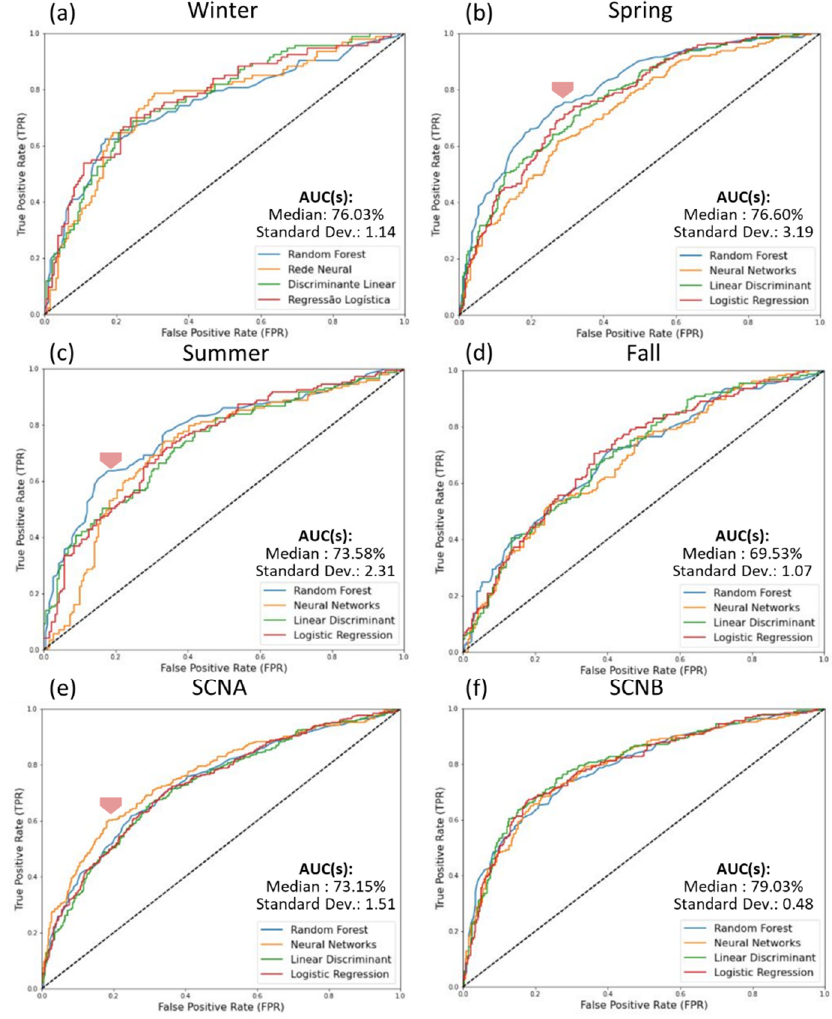
Figure 10. AUC(s) calculated for the 4 ML algorithms averaged over 100 cross-validation repetitions applied to ( a ) Winter, ( b ) Spring, ( c ) Summer, and ( d ) Fall seasons; ( e ) SCNA, and ( f ) SCNB modes.